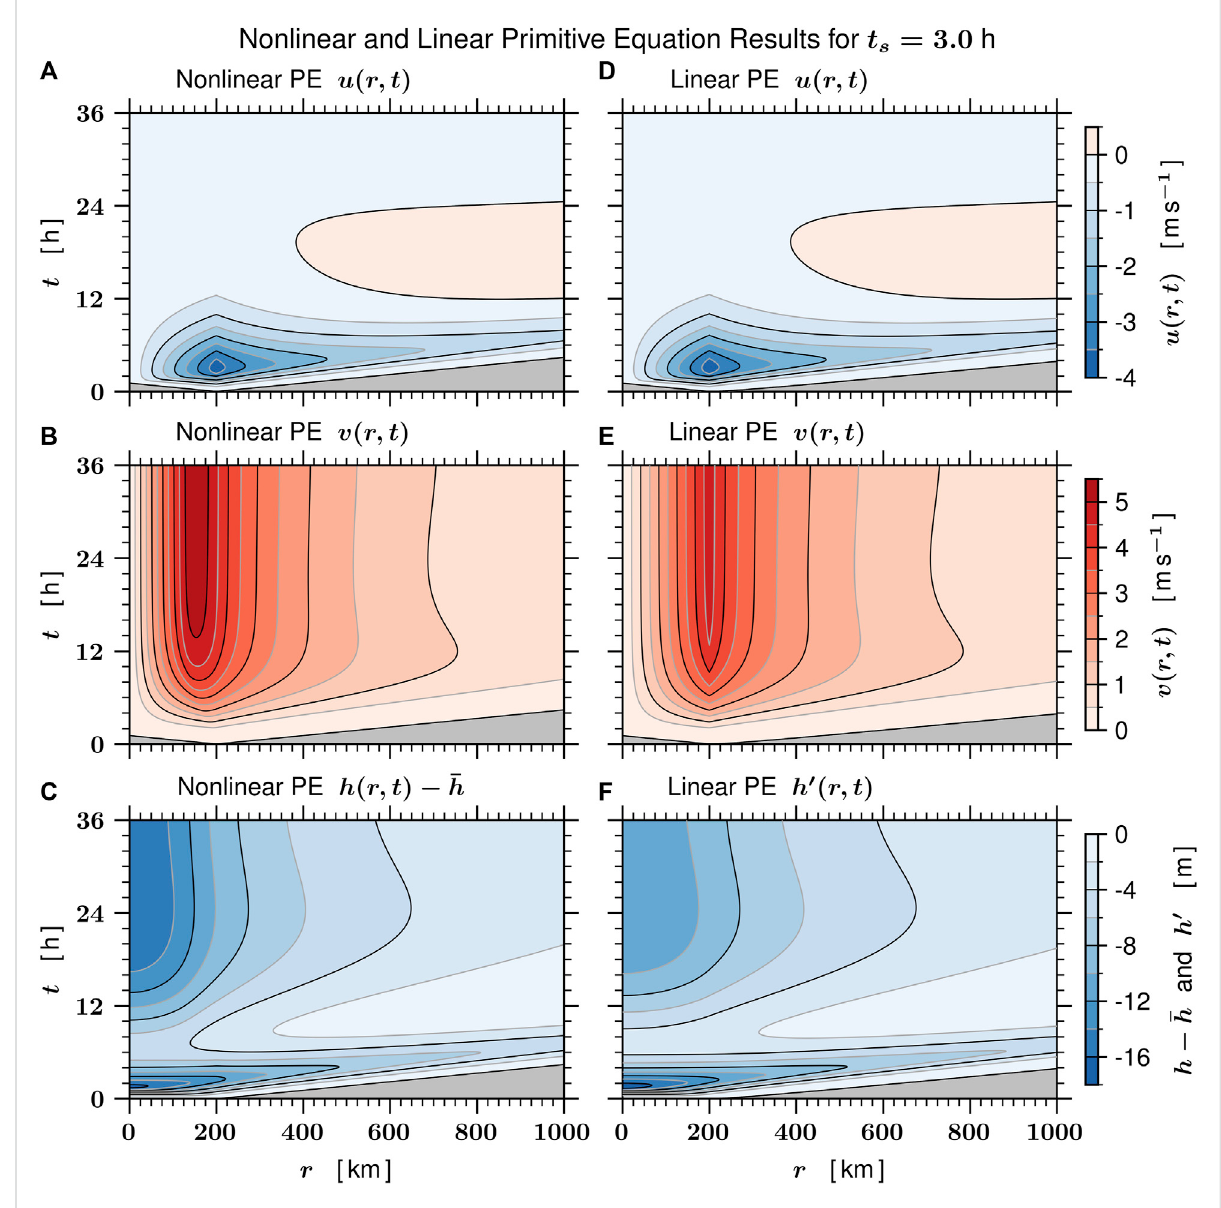
FIGURE 5 Panels (D-F) show the linear primitive equation solutions u ( r , t ), v ( r , t ), h ′ ( r , t ) for the rapid forcing case t s =3 h as shown previously in the right panelsofFigure2.Panels (A-C) showthenonlinearprimitiveequationsolutions u ( r , t ) , v ( r , t ) , h ( r , t ) − (cid:1) h obtainedfromEq.1fortherapidforcingcase t s =3 h obtained using the same parameters and forcing as those used for the linear results. The isoline intervals are identical to those used in the linear case (Figure 2), i.e., 0.5 m s − 1 for the radial and azimuthal fl ow and 2.0 m for the perturbation depth, and the gray regions again indicate initial regions where the plotted fi eld is zero. For the nonlinear results, the peak radial in fl ow is − 3.8 m s − 1 and occurs at r =200 km, the central depth anomaly h ( 0 , t ) − (cid:1) h approaches − 15.4 m as t → ∞ ,and themaximum azimuthal fl owapproaches 5.3 m s − 1 atabout r =150 km. Itfollowsthat,for 24 ≤ t ≤ 48h,theaveragerelativevorticityinside r =150 kmisapproximately 1.47 f .Amajor differencebetweenthelinearandnonlinear casesistheinward shift of the radius of maximum wind in the nonlinear case. Further discussion of this effect is given in Hack and Schubert